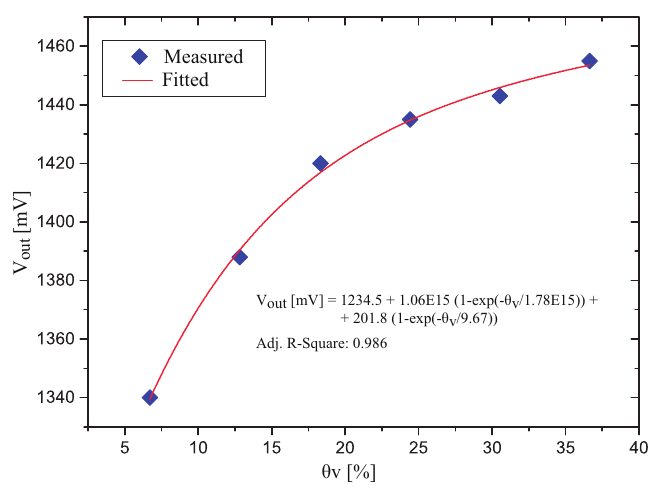
Figure 9. V out as a function of θ v in the porous ceramic.